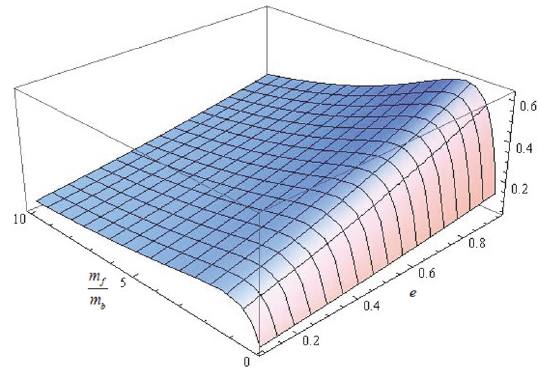
Figure 3: Ratio of converted rotational energy to total energy